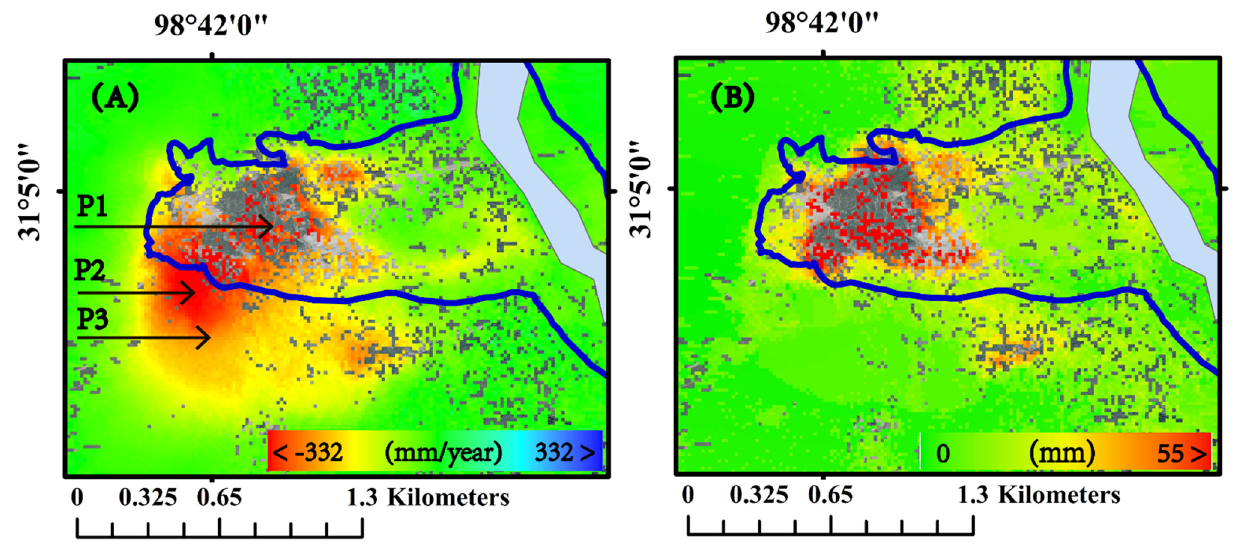
Figure 11. Post-failure Baige landslide deformation. ( A , B ) are the linear deformation rate and average STD of deformation time series, respectively. The blue polygon indicates the collapsed area in November 2018 and shows that the south side of the landslide is being deformed. The pixels P1 and P2 indicated by the arrows are shown in Figure 13.